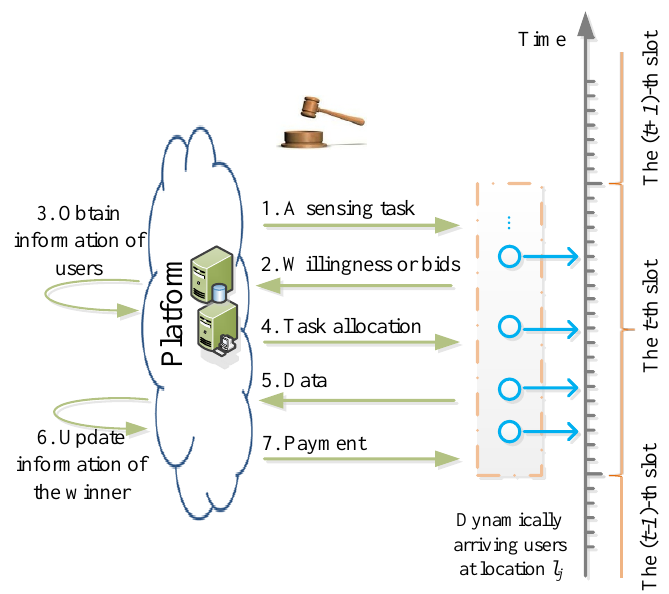
Figure 2. Our incentive framework for a mobile crowd sensing system with dynamic users and uncertain service